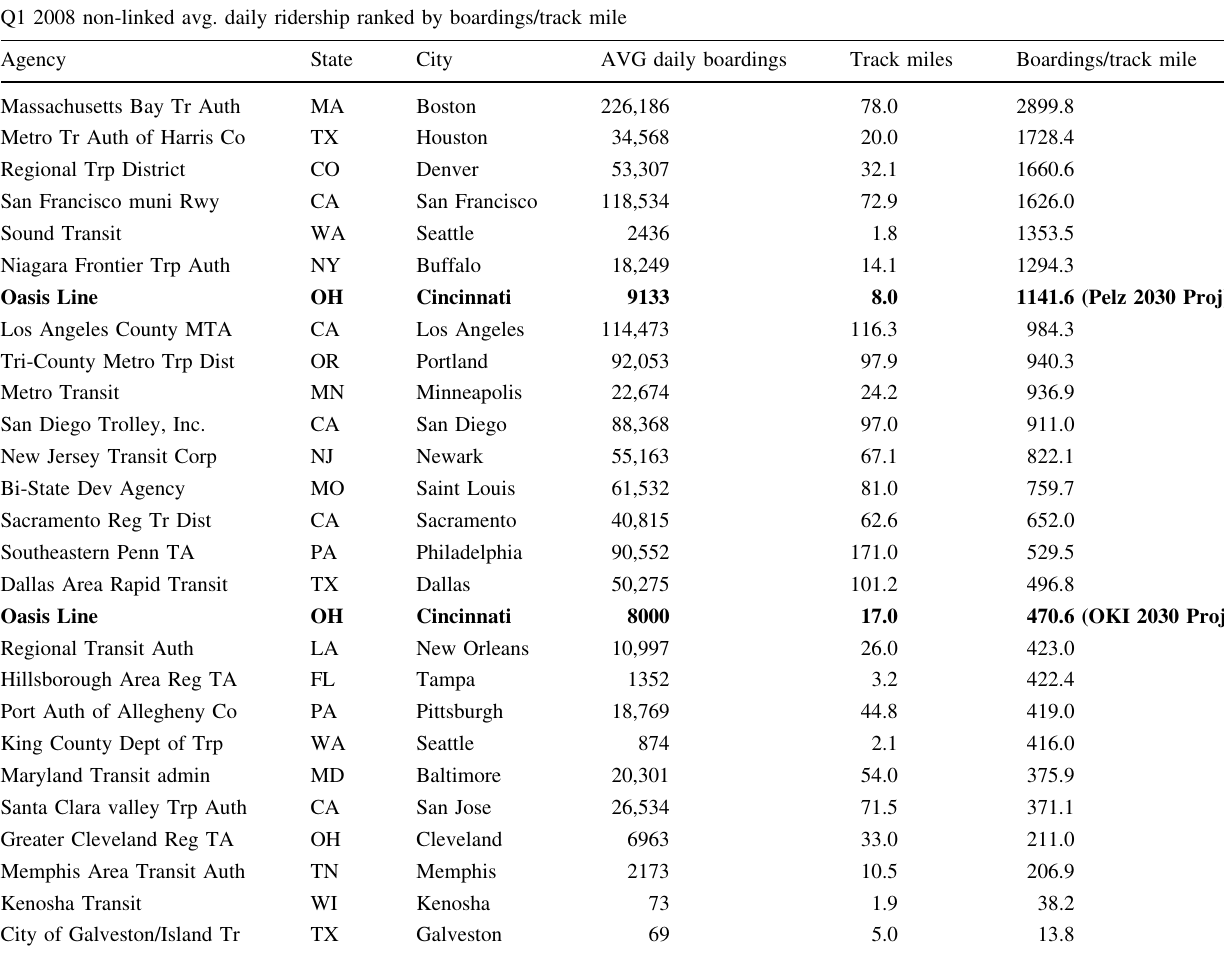
Table 3 Pelz and OKI 2030 forecasts ranked against national light rail systems, boardings per track mile [12], [15, 16] Q1 2008 non-linked avg. daily ridership ranked by boardings/track mile